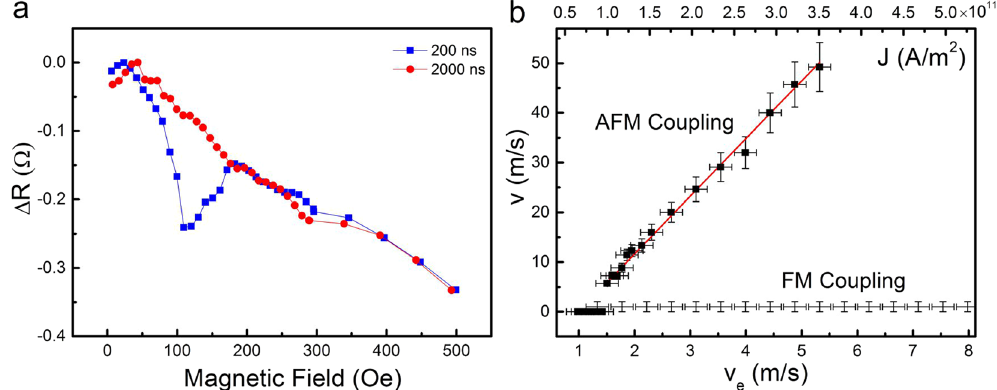
Figure 4. Effects of pulsed currents. ( a ) Pulsed current measurements for fixed current density and two different pulse durations showing current-driven DW speed measurement method. Short pulse duration, 200 ns, wire remains in the same magnetisation configuration. Long pulse duration, 2000 ns, wire magnetisation is fully switched and 180° DW removed. The pulse current density is 1.2 × 10 11 Am − 2 . ( b ) Current-driven DW mobility curve for AFM coupling obtained by determining the minimum average pulse duration required to fully remove the 180° DW between the measurement contacts for each current density value. The continuous line is a linear regression fit to the data points for values of v e above the threshold where the DWs are set in motion. Results obtained from FM coupled control samples are shown for